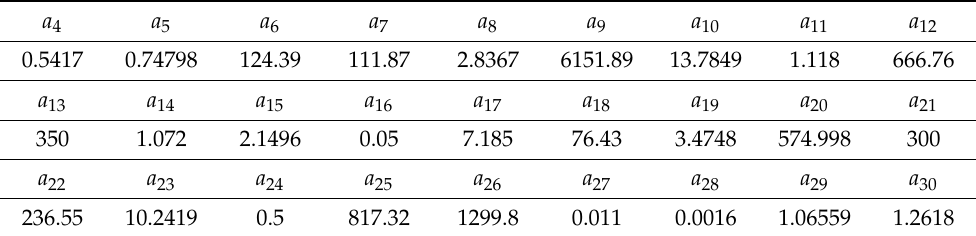
Table 6. Optimal coefficients in the phase transformation model for steel A.